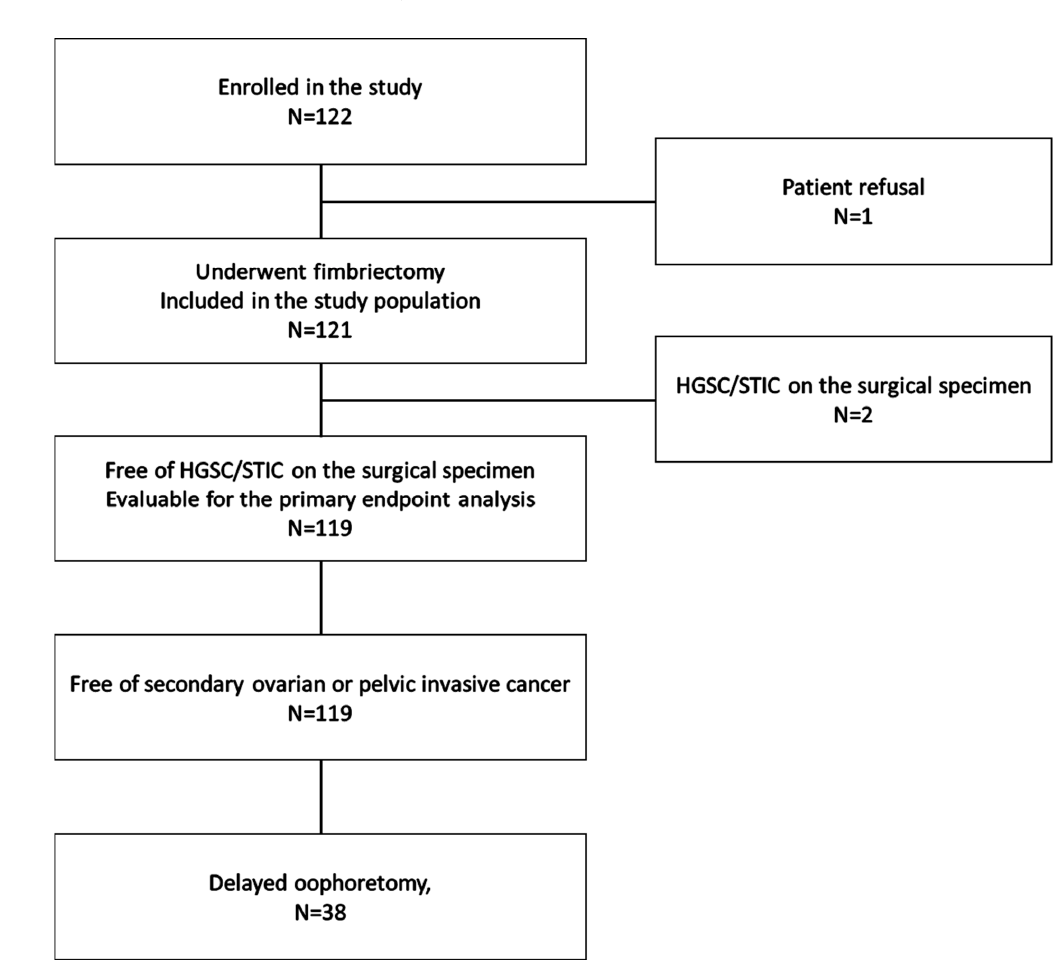
Figure 1. Participant flow.